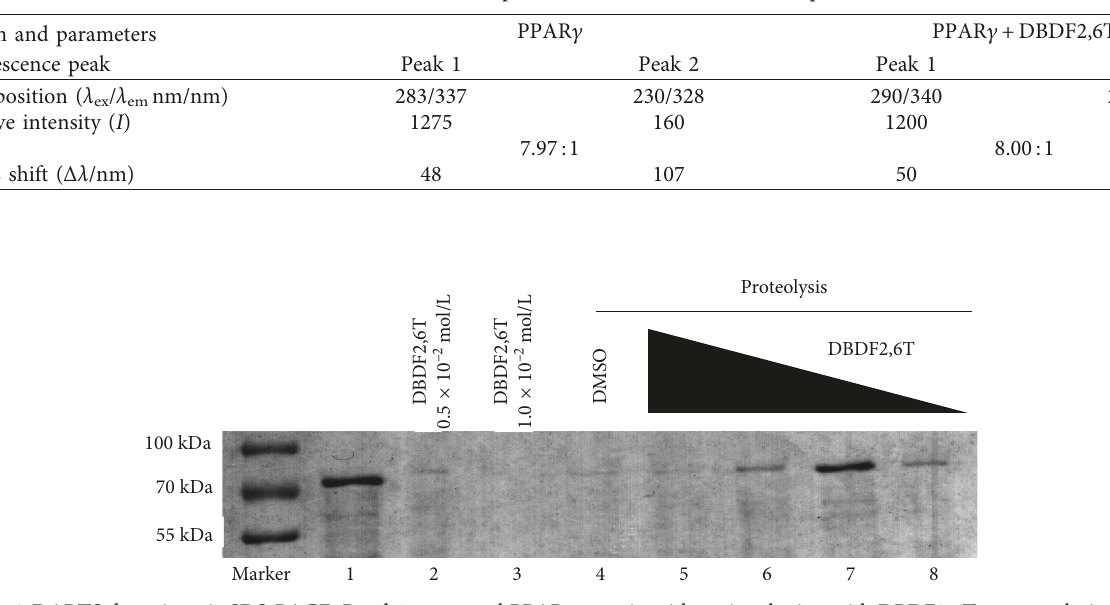
2 mol/L and 1.0 2 mol/L DBDF2,6T, respectively, and without proteolysis; bands 4 10 10 × × − −